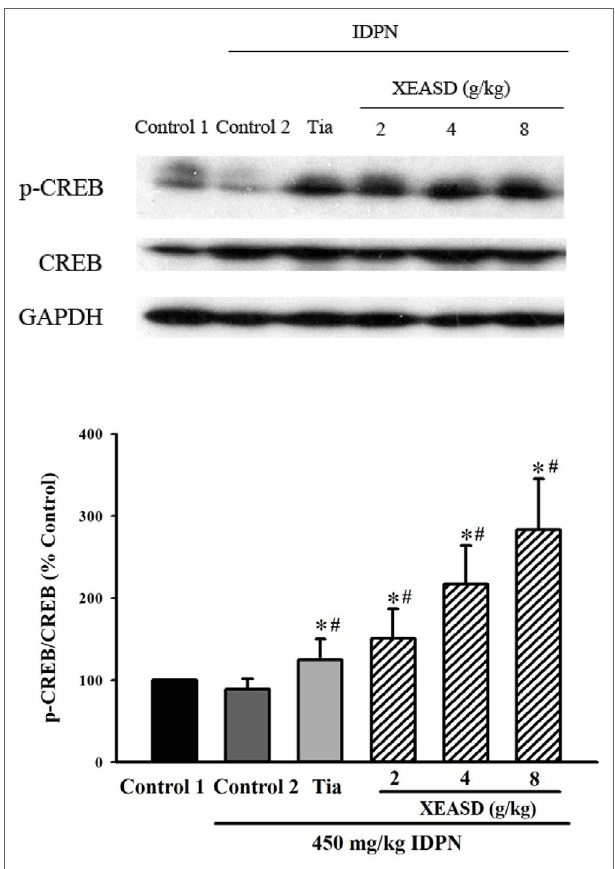
FIGURE 6 | Effects of XEASD treatment on the phosphorylation of CREB in brain tissue of IDPN-induced TS mice. Phosphorylated CREB and total CREB were measured by western blot analysis. Control 1 represents normal control mice; control 2 represents IDPN-challenged control mice. The values (arbitrary units) for phosphorylated CREB were normalized with reference to total CREB levels (arbitrary units) in the samples and expressed in % control 1. * P < 0.05, significantly different from the control 1; # P < 0.05, significantly different from the IDPN control